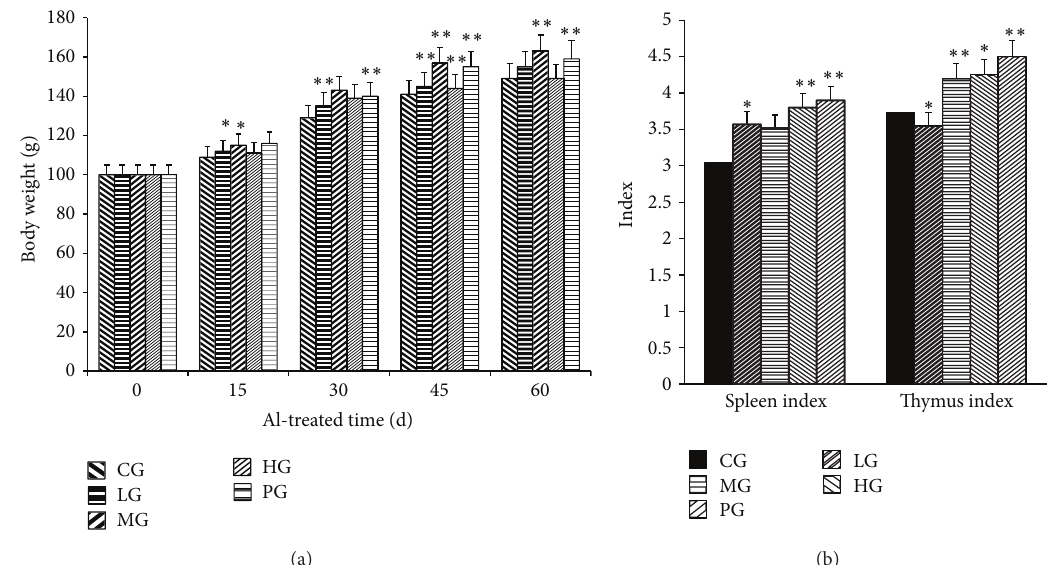
Figure 1: Effect of PFVM on changes of body weight (a) (body weight before treatment with PFVM was set at 100%) thymus index and spleen index (b) in mice. CG, control group; LG, low dose group; MG, medium dose group; HG, high dose group; PG, positive control group. ∗ 𝑃 < 0.05 , ∗∗ 𝑃 < 0.01 versus control group.